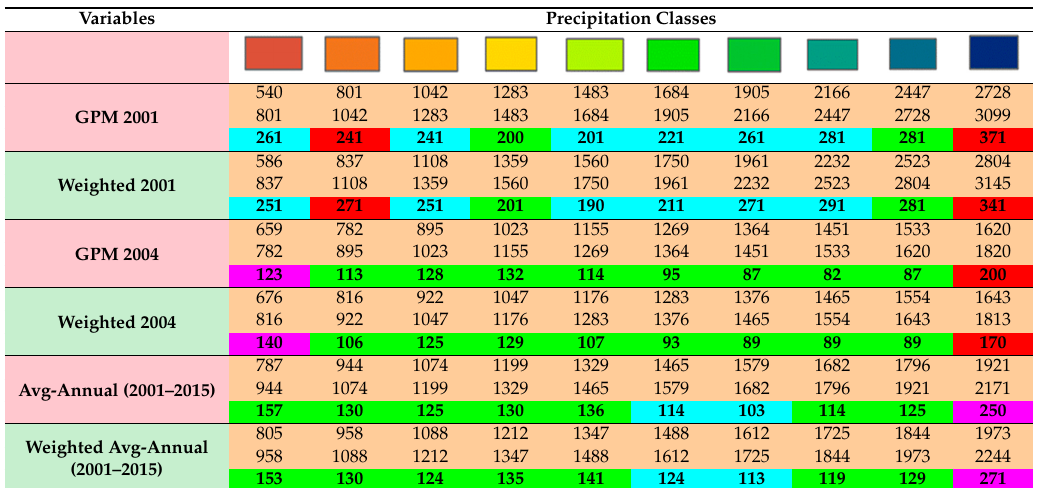
Note: Green colored values show the average di ff erence of less than 5 mm, Blue colored values show the average di ff erence of about 10 mm, Pink colored values show the average di ff erence of about 20 mm, Red colored values show the average di ff erence of about 30 mm between the GMP and weighted precipitation at particular pattern class,